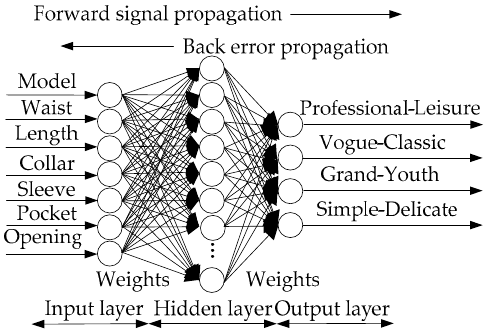
Figure 6. The structure of back-propagation (BP) neural network relationship model.